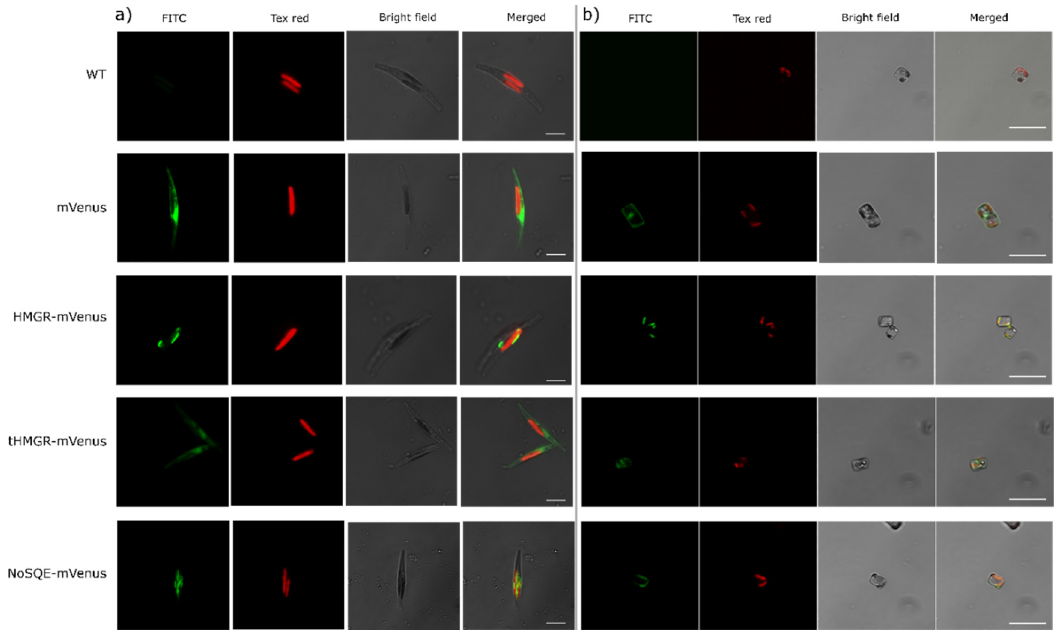
Figure 3. Confocal microscopy images showing subcellular localization of the mVenus fusion with target proteins in representative transgenic ( a ) P. tricornutum cells, scale bars correspond to 5 µm, and ( b ) T. pseudonana cells, scale bars correspond to 10 µm. Wild type (WT) as negative control and control cell lines that only expressed mVenus. 3-hydroxy-3-methylglutaryl-coenzyme A reductase, HMGR-mVenus; truncated HMGR, tHMGR-mVenus; squalene epoxidase from N. oceanica , NoSQE-mVenus. Scale bars correspond to 10 µm.